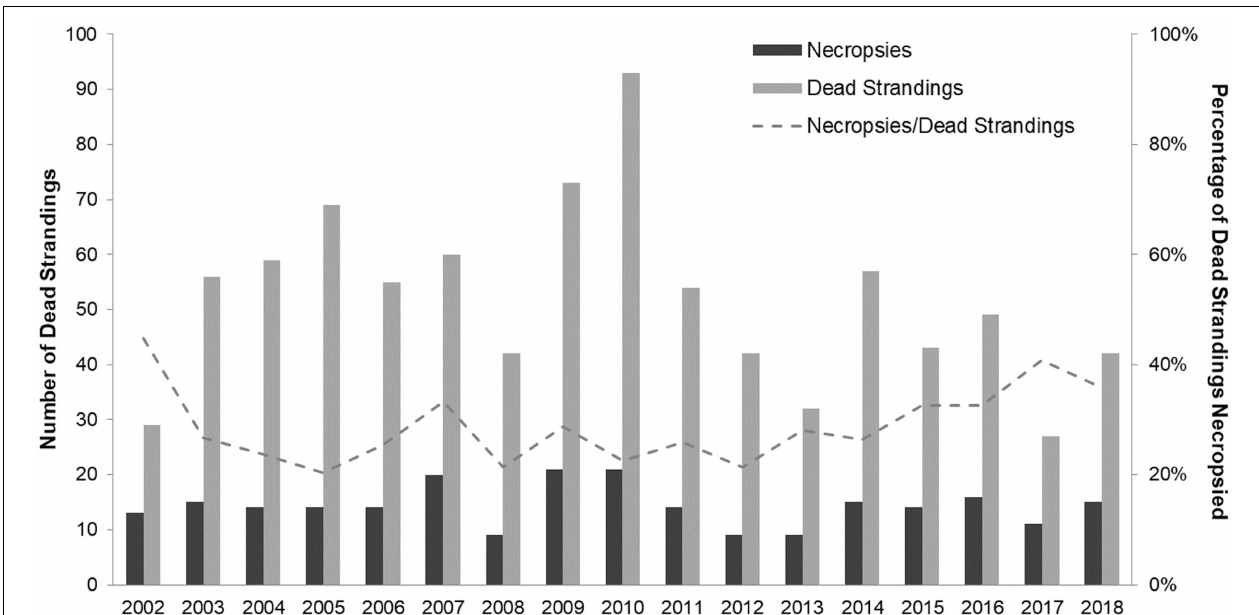
FIGURE 2 | Annual count of dead stranded harbor seals (including live seals that died or were euthanized in rehabilitation) by year (mean = 51.8 ± SD = 16.8) and annual number of harbor seal necropsies performed (mean = 14.3 ± SD = 3.74) in San Juan County between 2002 and 2018. Line graph is the ratio of harbor seals necropsied per year to the total number of harbor seals dead-stranded per year (mean = 28.8% ± SD =